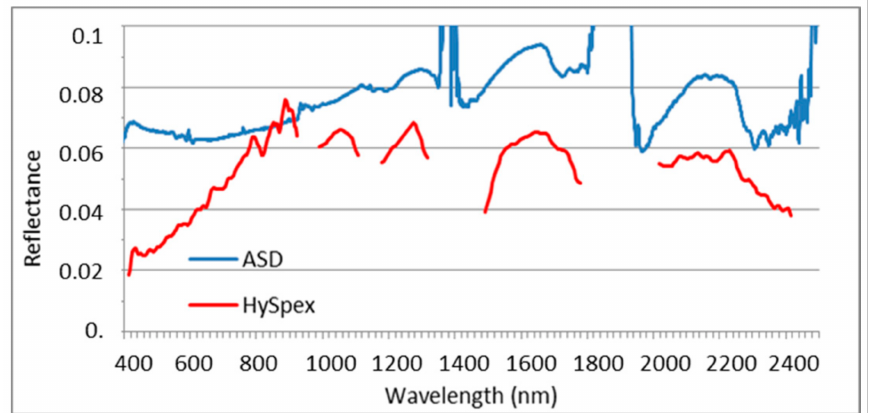
Figure 16. Spectral reflectance of the tar pit acquired with HySpex and measured in the laboratory using an ASD FieldSpec spectroradiometer.